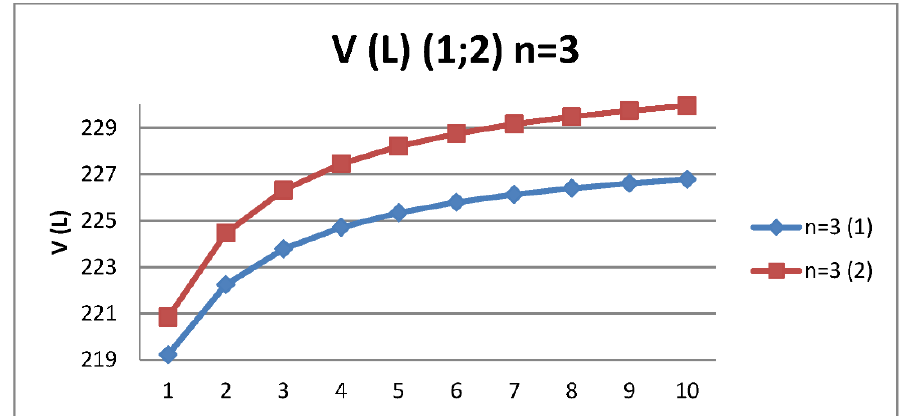
Figure 2. Dependence of the company value, V , on leverage level L in the cases of payments of tax on profit at the end of the year (1) and in the beginning of the year (2) for three-year company.